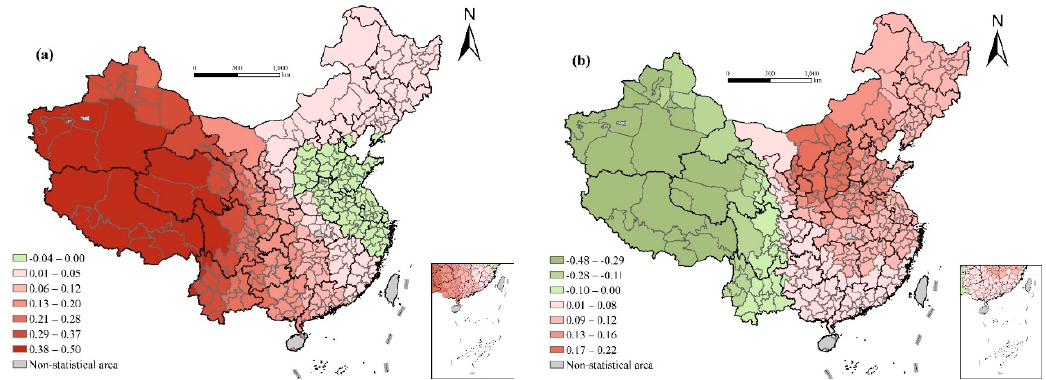
Figure 4. Spatial variation of regression outputs from the GWR model: ( a ) per capita GDP (ln); ( b ) urbanization rate.